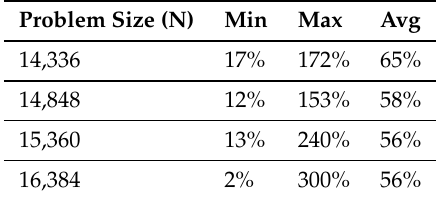
Table 9. Prediction errors of RAPL against HCLWattsUp for dynamic energy consumption by